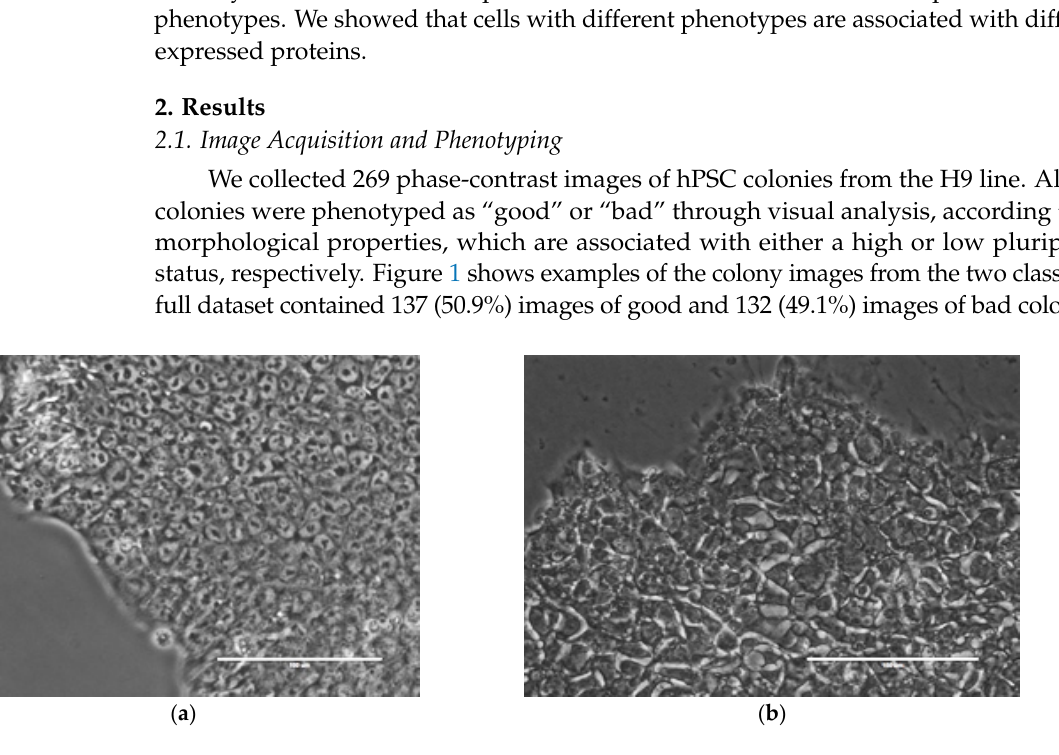
Figure 1. Examples of hPSC colonies with ( a ) good and ( b ) bad phenotypes. Criteria for visual assessment of morphological features associated with the phenotype are given elsewhere [11]. Scale bar, 100 μ m. More examples are shown in Figure S1.